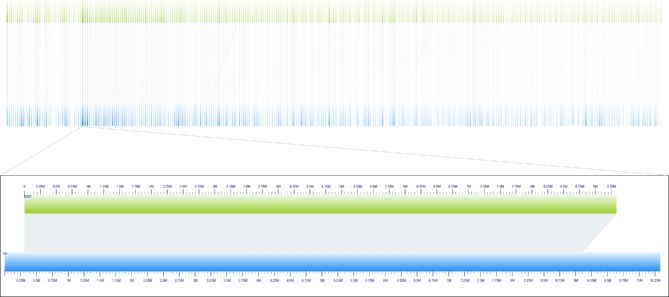
Physical map comparison of M. pentadactyla and M. javanica. The physical maps of M. pentadactyla and M. javanica were compared based on sequence similarity. The physical map of M. pentadactyla is shown at the top and M. javanica is shown at the bottom. The line in the middle shows the links between similar regions. The comparison shows that the two species have high similarity at the physical map level (greater than 97% aligned to each other). However, some areas contained insertions/deletions or inversions (below)